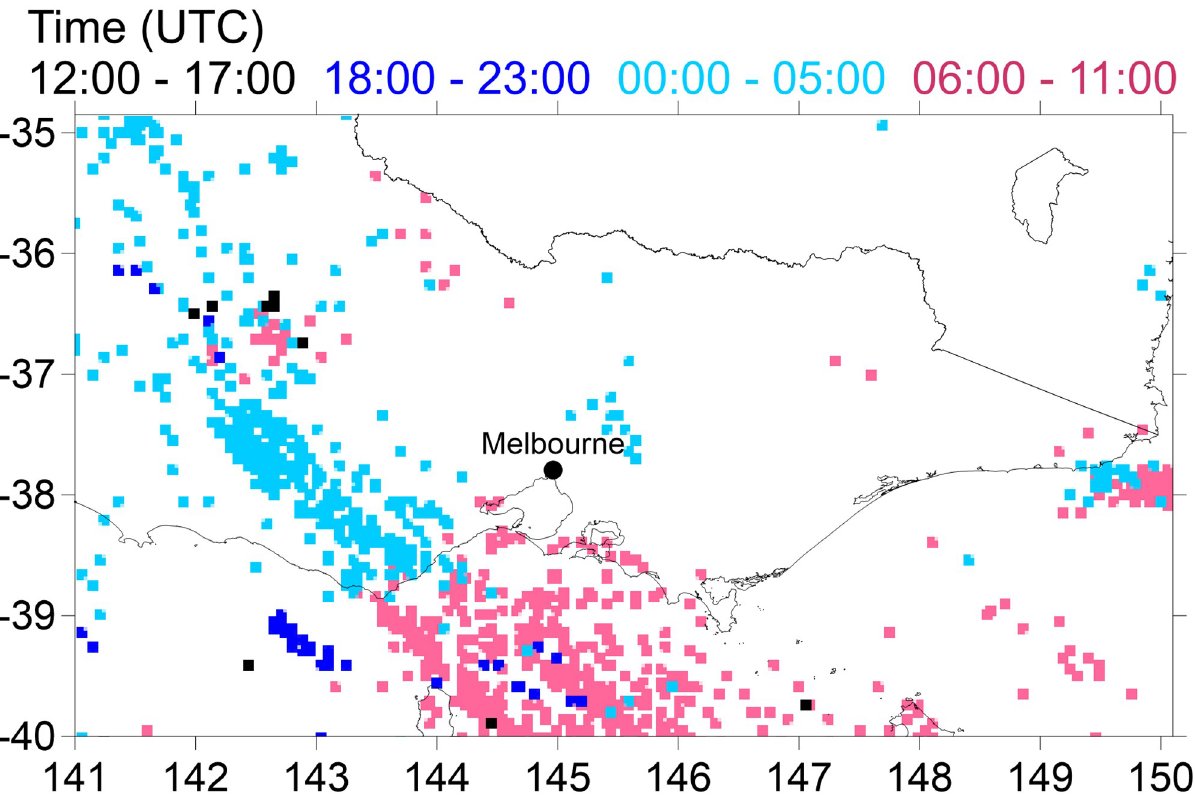
Fig 7. Location of lightning occurrences in 6-hourly blocks starting late 20 November into 21 November 2016. The pink pixels coincide with timing of the storm passing Melbourne. Basemap from Igismap.com 2020.